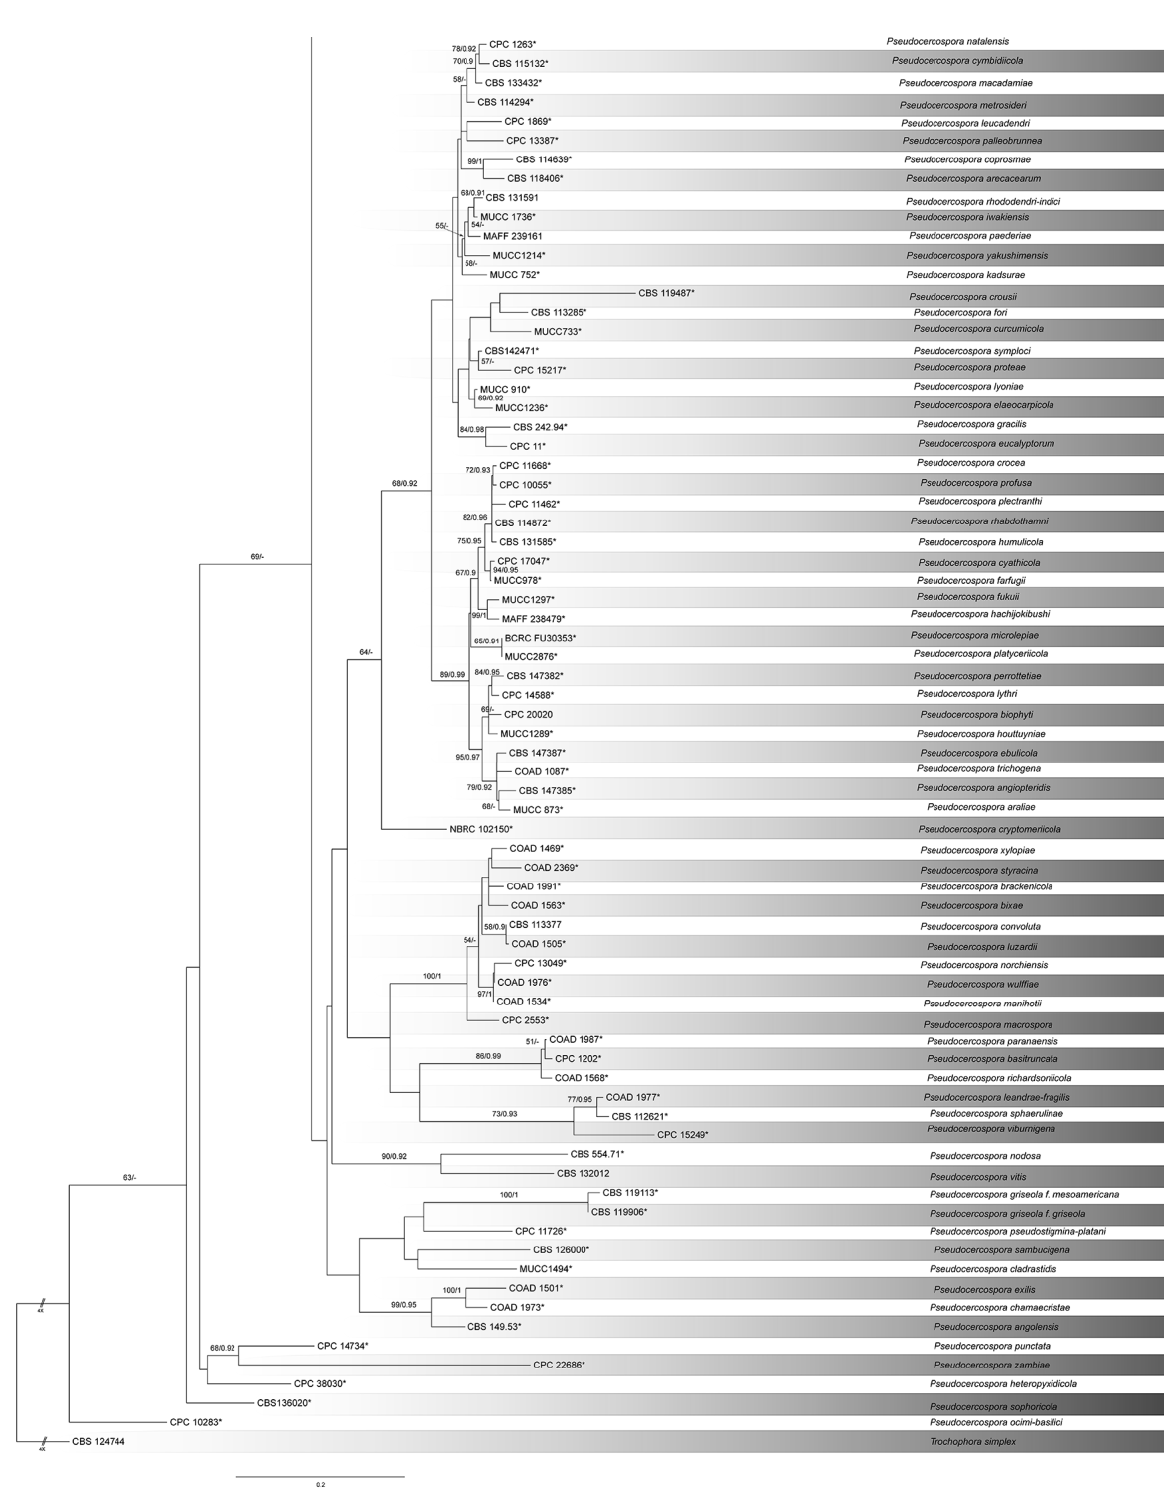
Figure 2. Phylogram of Pseudocercospora resulting from a maximum likelihood analysis, based on a combined matrix of ITS, LSU, act , rpb2 and tef1 . Numbers above the branches indicate ML bootstraps (left, ML BS ≥ 50%) and Bayesian Posterior Probabilities (right, BPP ≥ 0.90). Ex-type strains are marked with *, and the new species proposed in the present study is marked in blue.